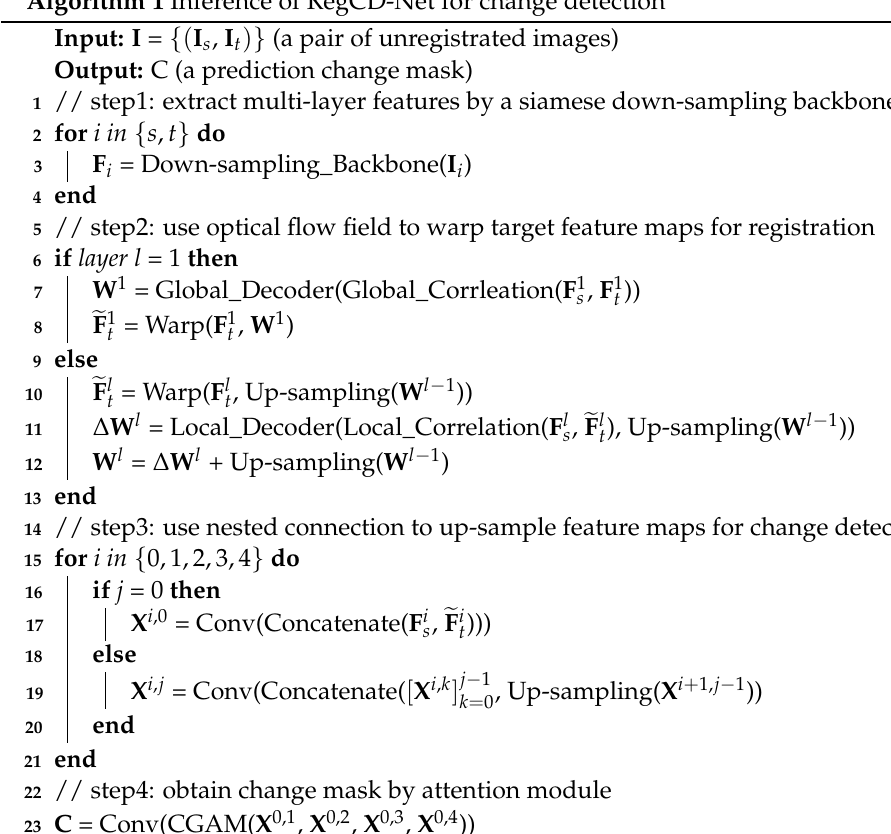
Algorithm 1 Inference of RegCD-Net for change